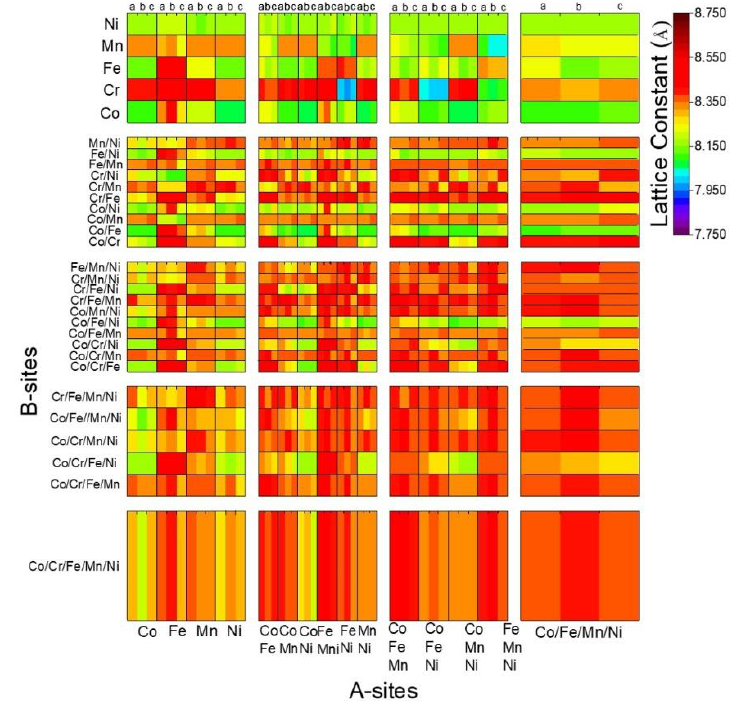
Figure 2. The predicted lattice constants of the spinel-structured HEOx with different metal cations in the A and B